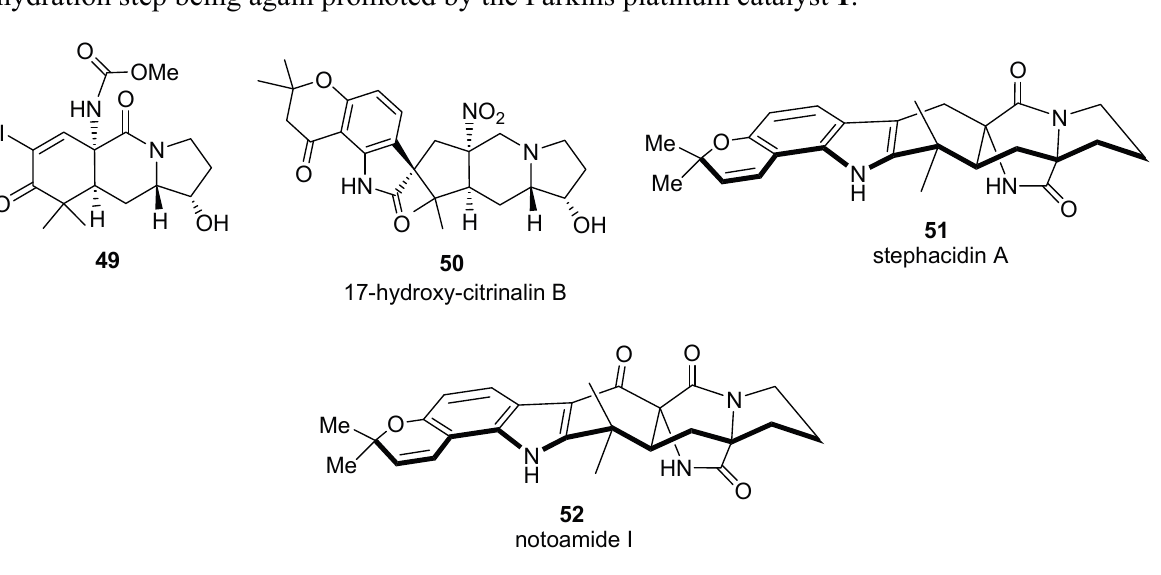
Figure 4. Structure of the carbamate 49 and the alkaloids 50 – 52